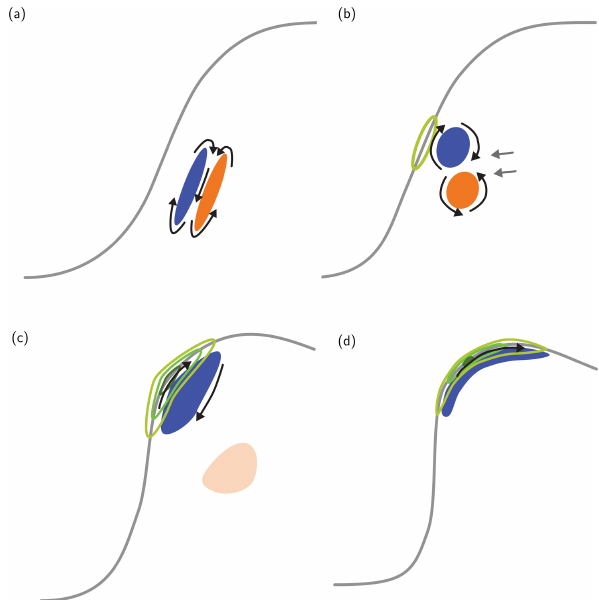
Figure 13. Schematic illustration of different stages of convectively generated PV (orange and blue colors for the positive and negative PV poles, respectively) and the associated jet structure (green con- tours); (a) PV dipole band; (b) meridional alignment; (c) distorted negative PV and weakened positive PV (light orange); (d) stretched negative PV band. See text for